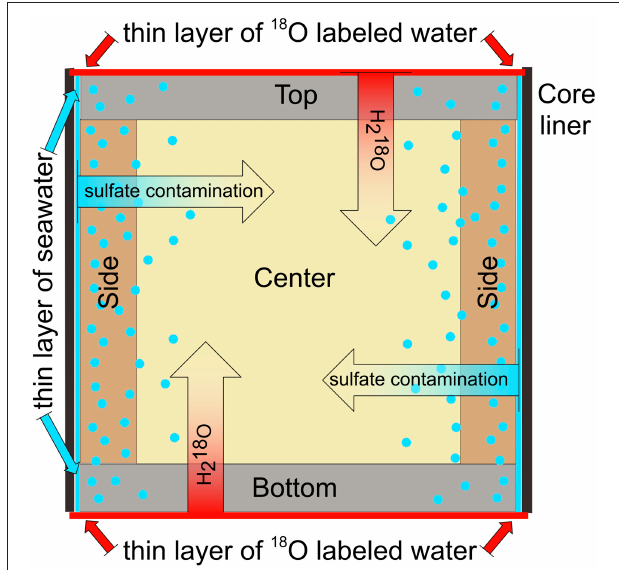
FIGURE 5 | Cross-section of whole-round core segment depicting potential contamination with sulfate from seawater and the experimental procedure with 18 O labeled water to quantify potential sulfate